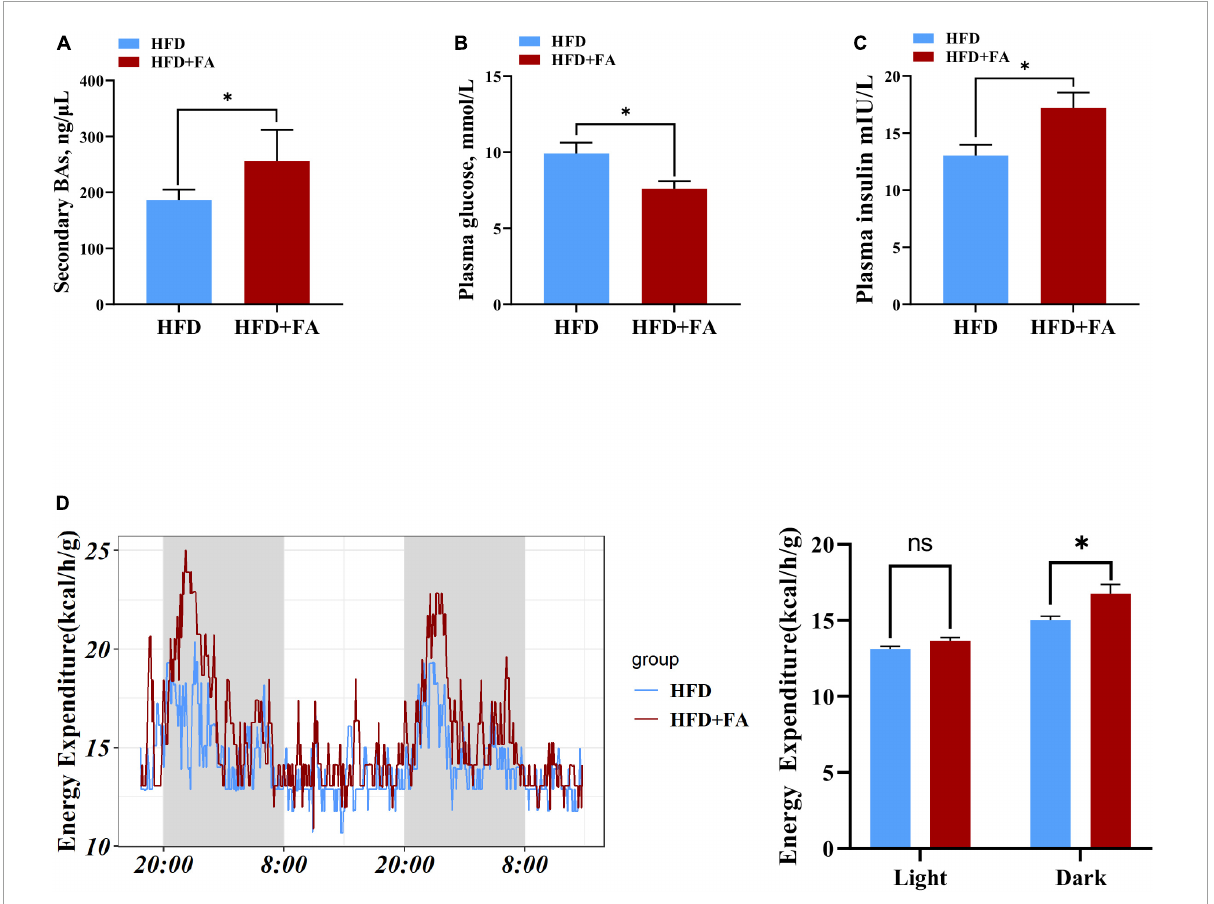
FIGURE6 FA decreases fasting glucose and increases energy expenditure. (A) Serum total secondary BAs in the HFD and HFD + FA mice ( n = 6). (B) Plasma insulin level after 6 h fasting in the HFD and HFD + FA mice ( n = 8). (C) Plasma glucose level after 6 h fasting in the HFD and HFD + FA mice ( n = 8). (D) Energy expenditure of mice from HFD and HFD + FA groups ( n = 4). Data are presented as mean ± SEM. ∗ p < 0.05, ns, no significance. HFD, high-fat diet group; HFD + FA, high-fat diet with 100 mg/kg bw/day FA